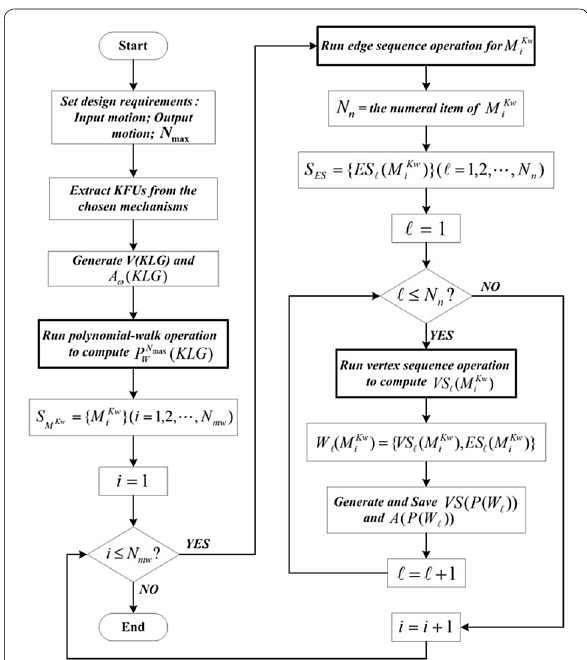
Figure 7 Computational flowchart of the synthesis